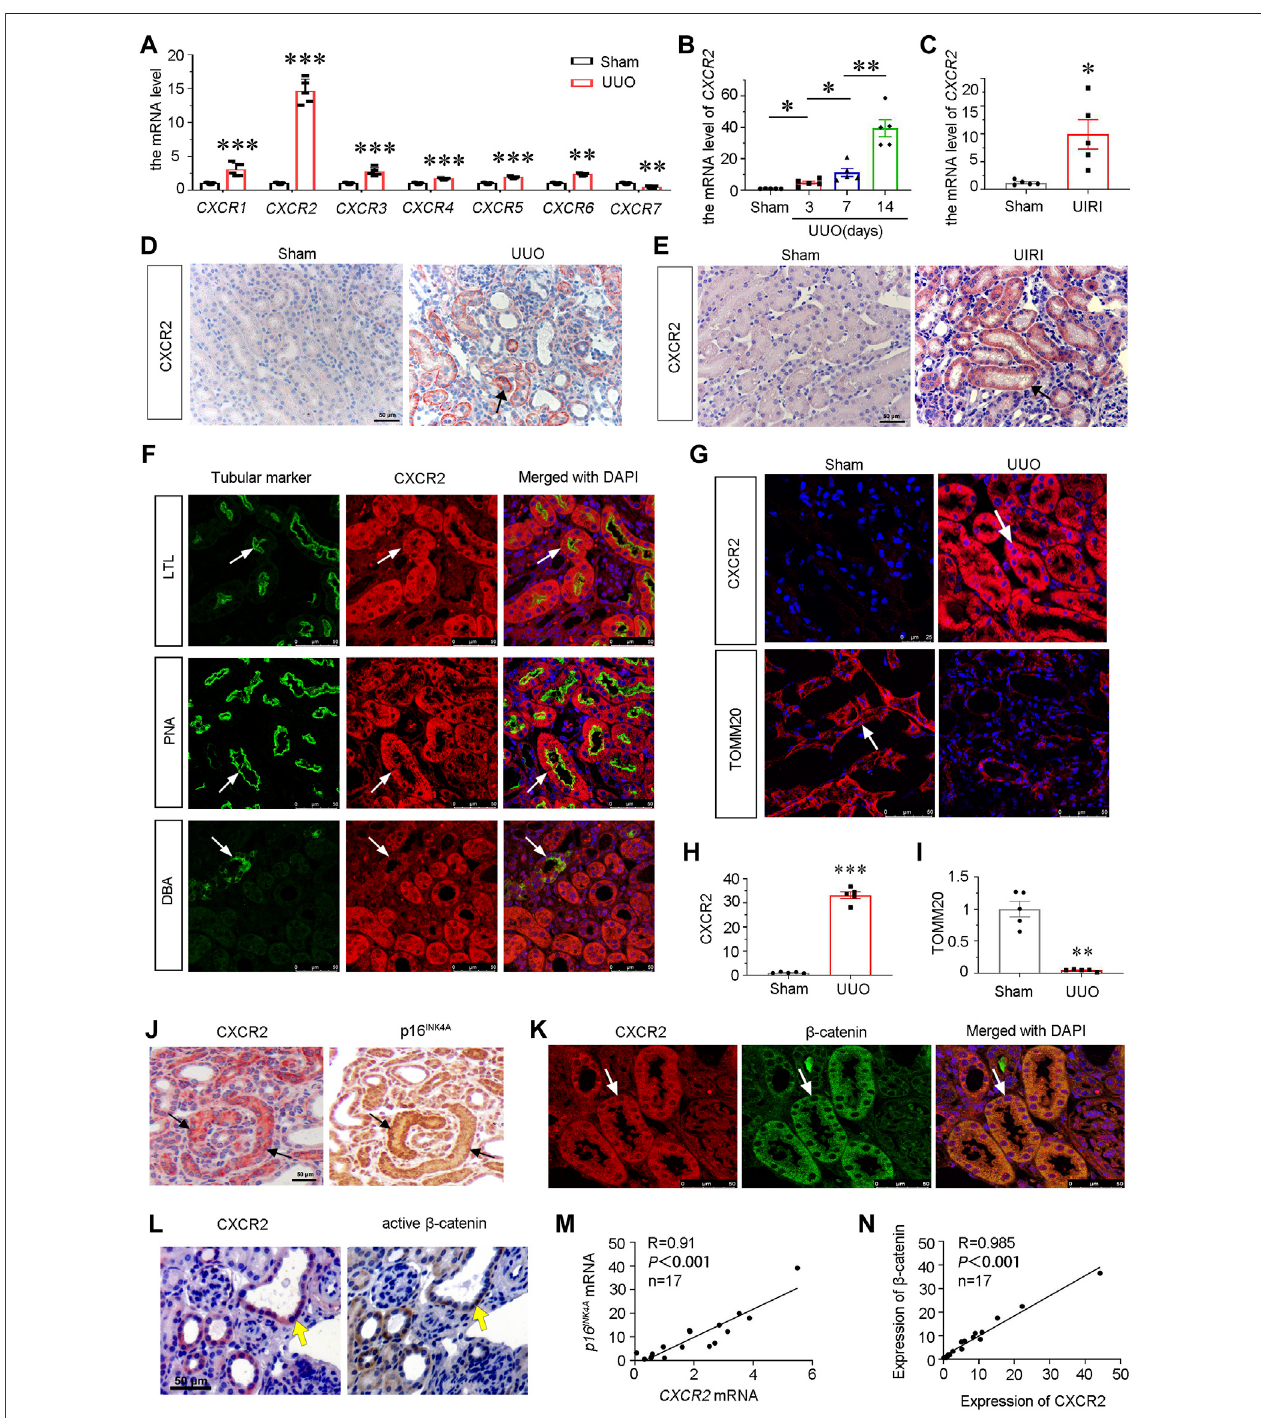
FIGURE 1 | CXCR2 is upregulated in renal tubular epithelium and associated with tubular senescence and activation of β -catenin in mouse CKD model. (A) Graphical representations show the relative abundance of CXCR1-7 mRNA in UUO model. ** p < 0.01, *** p < 0.001 compare with sham controls ( n = 5). (B) Graphical representations show the relative abundance of CXCR2 mRNA level in different groups of UUO 3, 7, 14 days * p < 0.05, ** p < 0.01, n = 5. (C) Graphical representations show the mRNA level of CXCR2 in UIRI model. * p < 0.05 versus sham controls ( n = 5). (D,E) Immuohistochemical staining show the expression of CXCR2 in UUO andUIRImodels.Arrowsindicatepositivestaining.Scalebar,50 μ m. (F) ColocalizationstainingofCXCR2andvarioussegment-speci fi ctubularmarkersinthekidneysof UUOmodel.Frozenkidneysectionswerecollectedfromthemiceat7 daysafterUUO.CXCR2(red)andvarioussegment-speci fi ctubularmarkers(green)includinglotus tetragonolobus lectin (LTL), peanut agglutinin (PNA), and dolichos bi fl orus agglutinin (DBA) were detected by immuno fl uorescence. Arrows indicate positive staining.